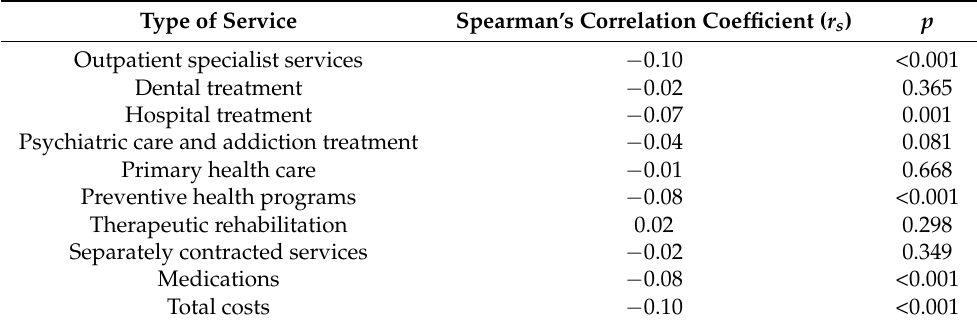
Table 4. Correlation between age and the change in the cost of postoperative treatment compared to preoperative